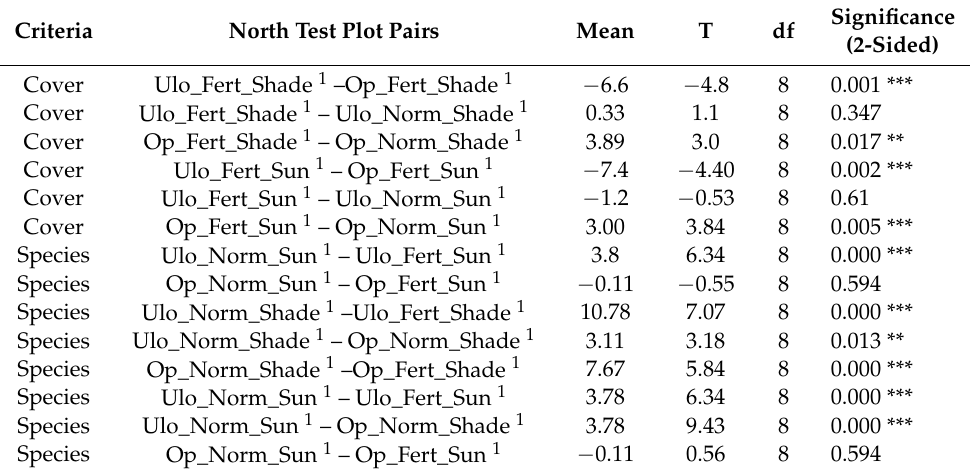
Table 15. Greening with turf mats, n = 9 years, from 2011 to 2020 (df 8), coverage and number of species for the test plots with fertilizer (Fert.) and without (Normal) of the northern position: North Shade: in the shade of an elevated section of the building. Sun_N: North, outside this shade. Pairwise t -test and the level of significance. Example explanation line 1 of Table 15: The minus sign in category “means” symbols lower cover values of the first element of the pair. As example: Athough Ulo and Op were fertilized, over the time, Ulo has all the times lower cover values than Op on the highest level of 1‰ level.